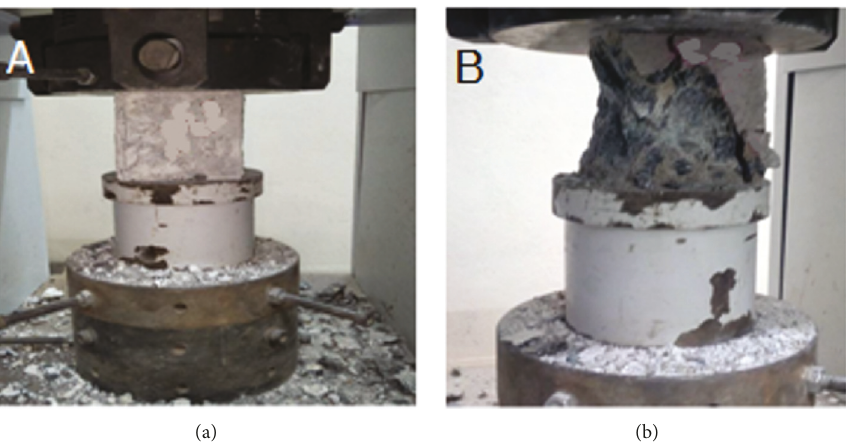
Figure 11: Compressive testing of sulphate cured (a) conventional and (b) geopolymer concrete cube specimens.